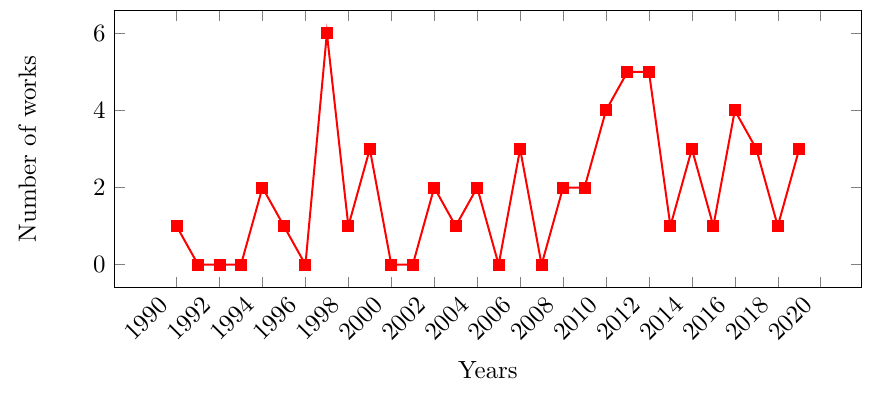
Figure 2. Timeline of publications.